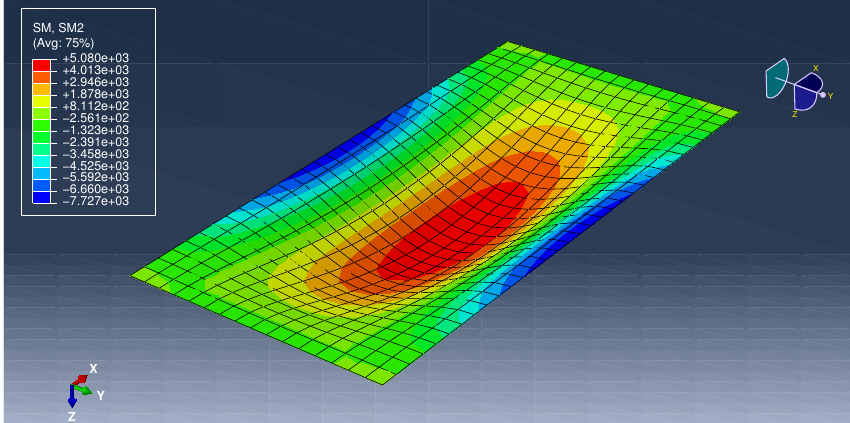
Figure A9. The bending moment M 22 of a rectangular plate with clamped edges solved using